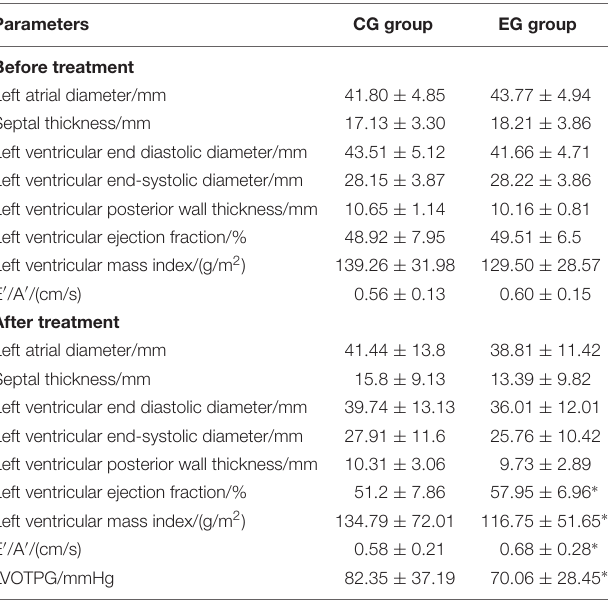
TABLE 2 | Conventional echocardiography.